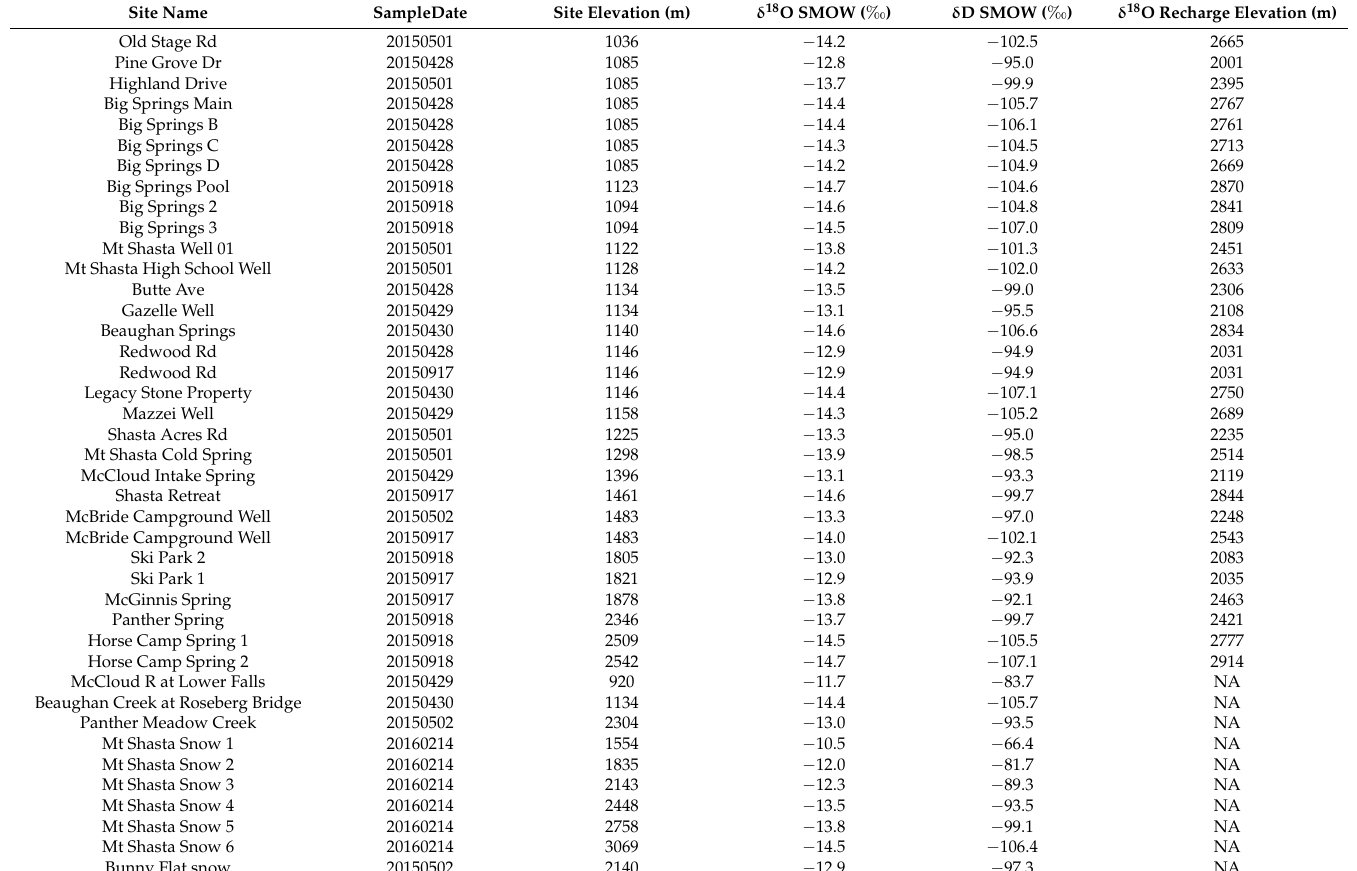
Table A3. Stable isotope